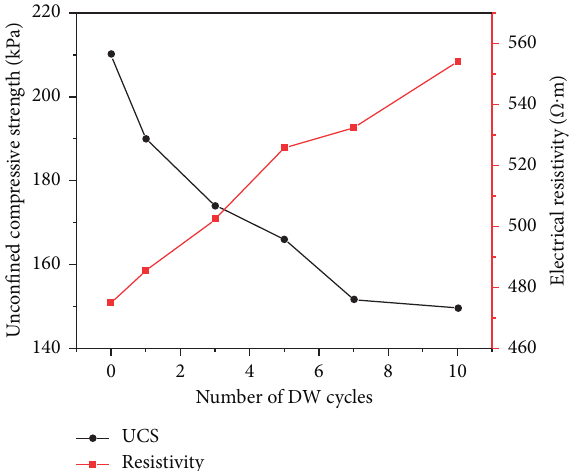
Figure 12: Relationship between UCS, number of DW cycles, and electric resistivity of